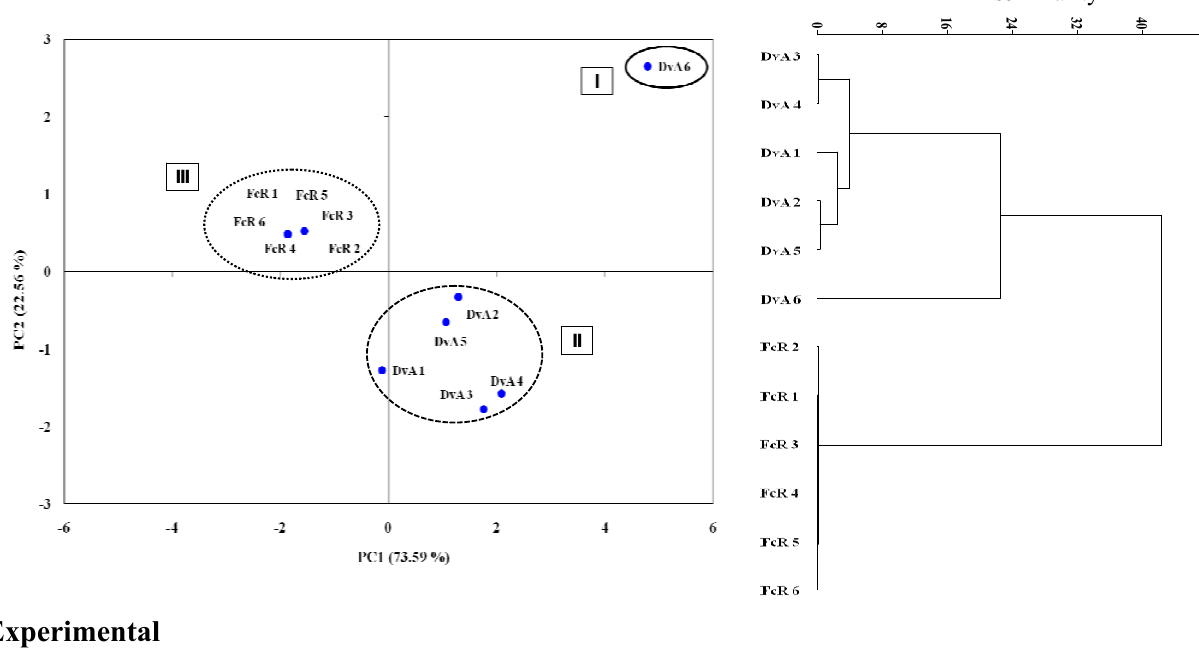
Figure 7. Classification of plant extracts according to conidia germination of six postharvest fungi by PCA and cluster analysis. The percentage of total variance explained by each axis in PCA is shown. Numbers from 1 to 6, represent the pathogens